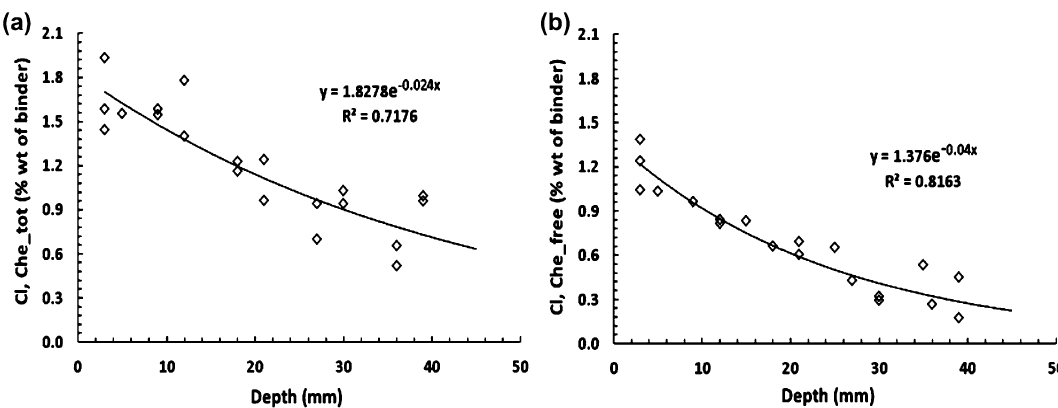
Fig. 15 Level of chemical total chloride contents at different depths of R/SHCC